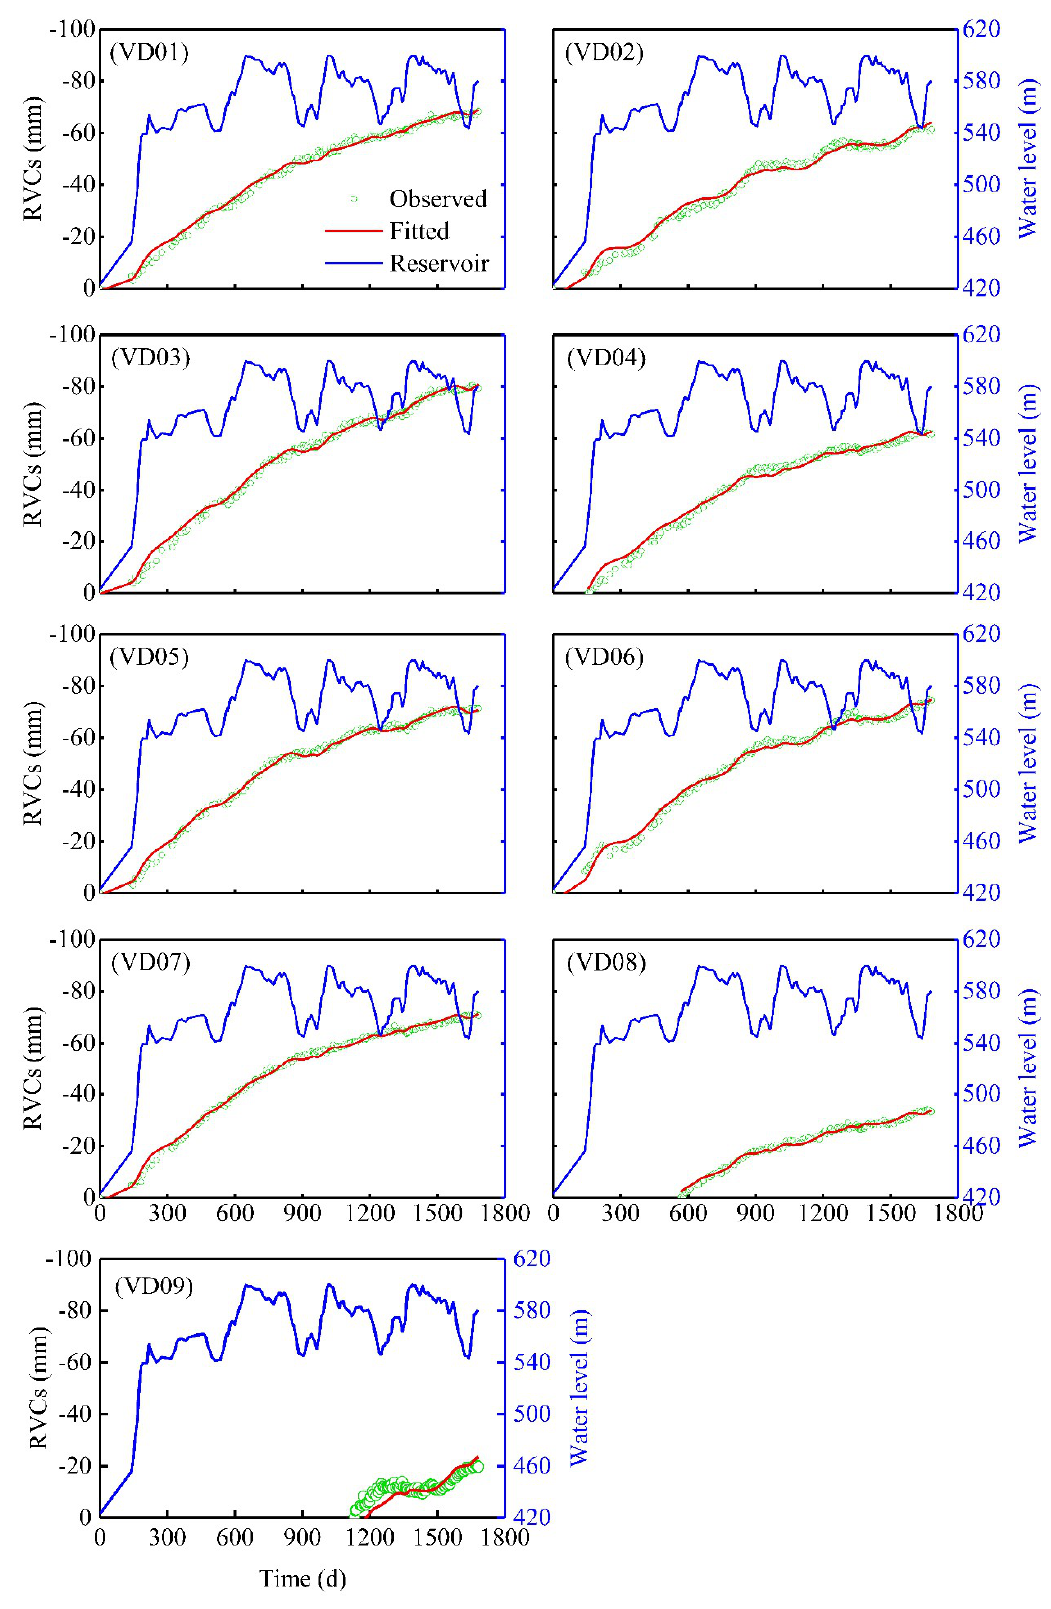
Figure 7. Simulated versus observed RVCs development.